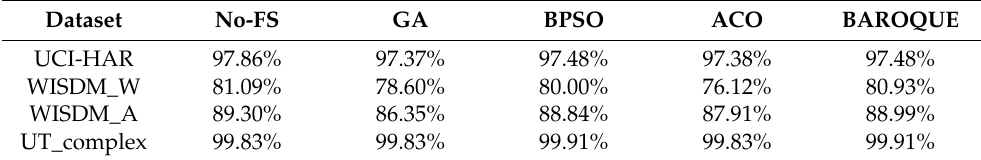
Table 5. Comparison between BAROQUE and other swarm-based algorithms in terms of accuracy. Dataset No-FS GA BPSO ACO BAROQUE UCI-HAR 97.86% 97.37% 97.48% 97.38% 97.48% WISDM_W 81.09% 78.60% 80.00% 76.12% 80.93% WISDM_A 89.30% 86.35% 88.84% 87.91% 88.99% UT_complex 99.83% 99.83% 99.91% 99.83%